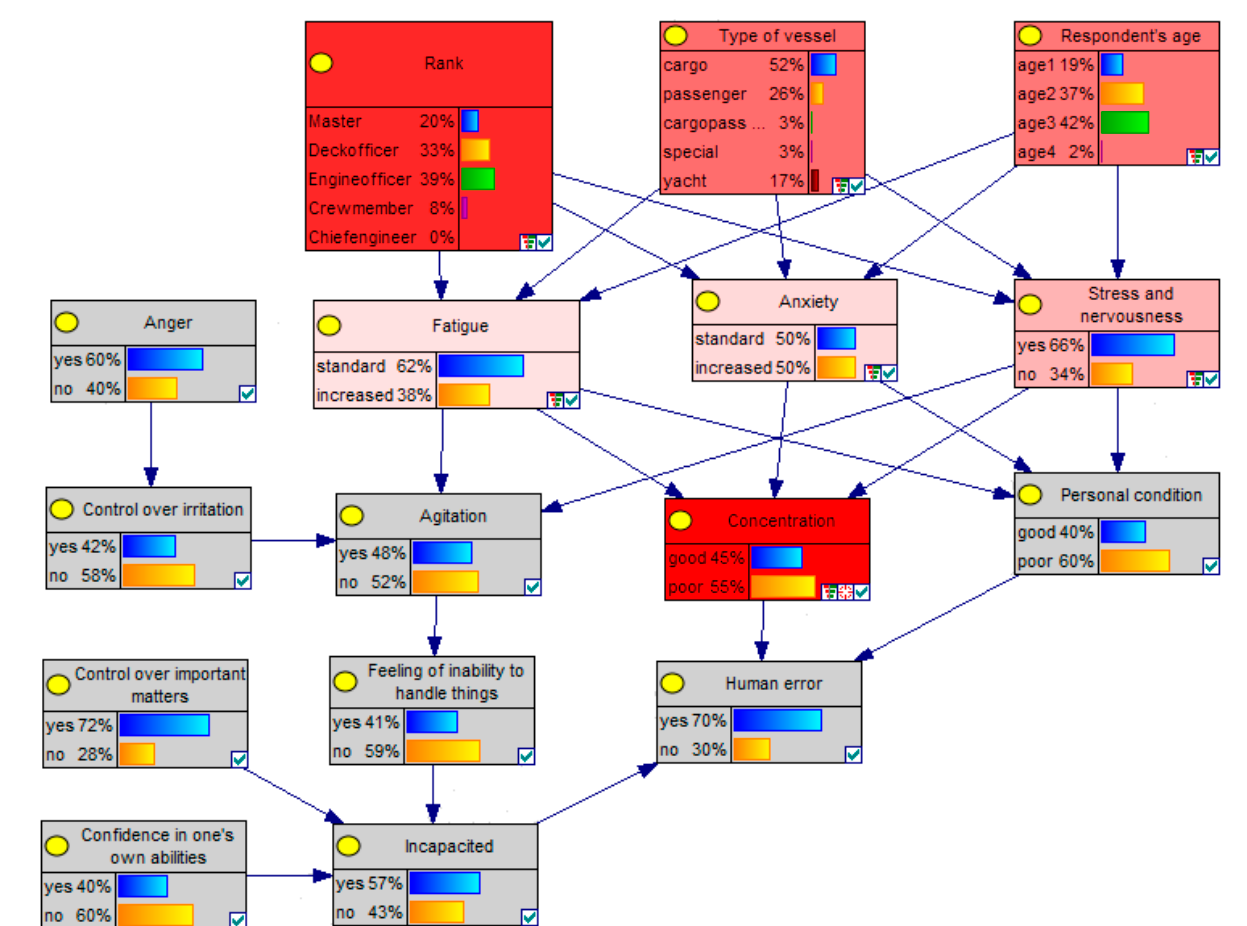
Figure 9. Presentation of sensitivity by targeting the variable Concentration .